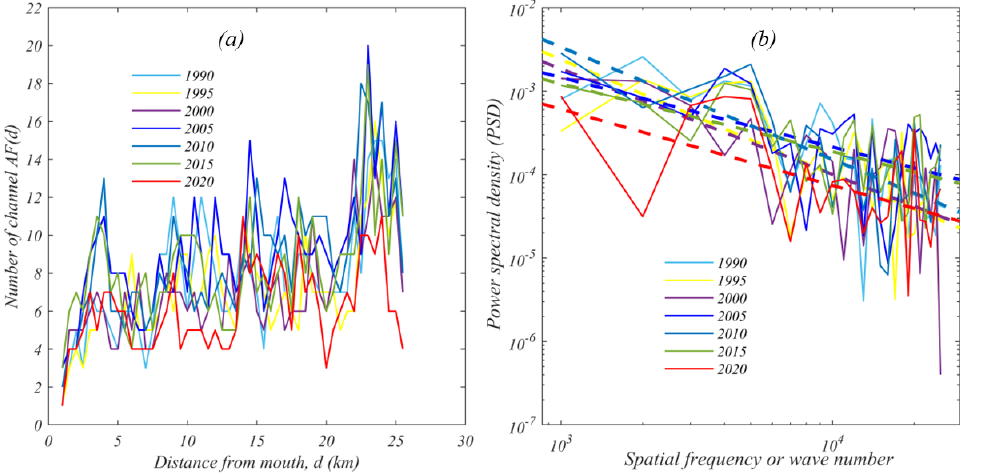
Figure 6. ( a ) Extracted AF for the BR for the seven selected years and ( b ) corresponding PSD of AF plotted on a log–log